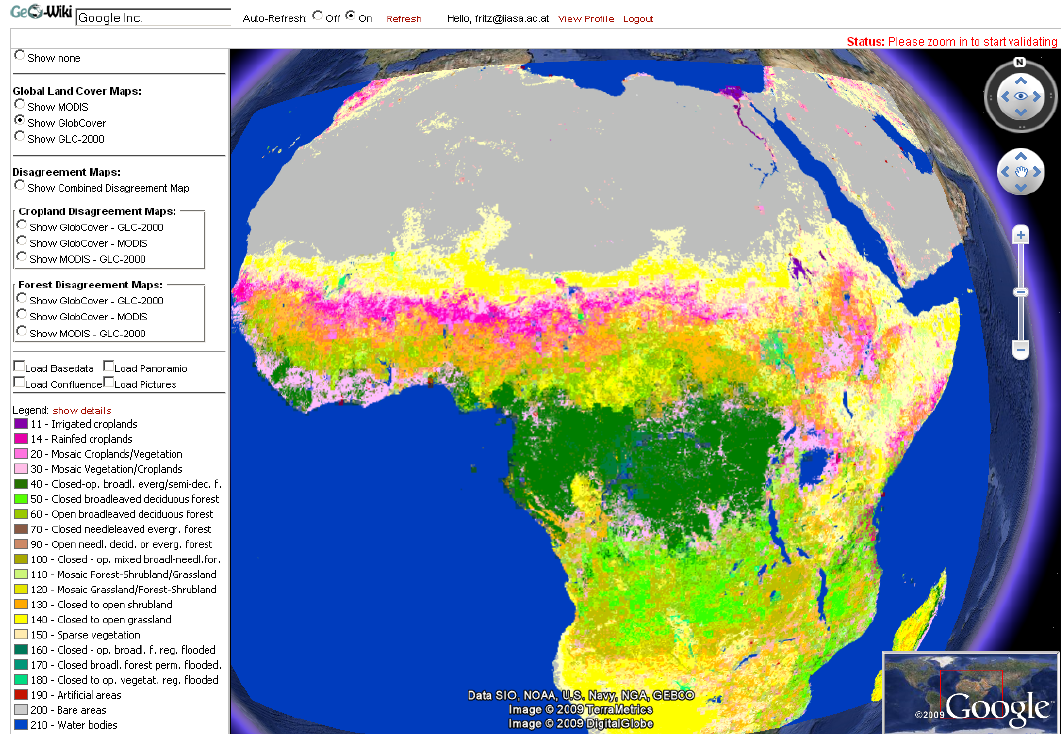
Figure 1. Displaying the different land cover classes of GlobCover over